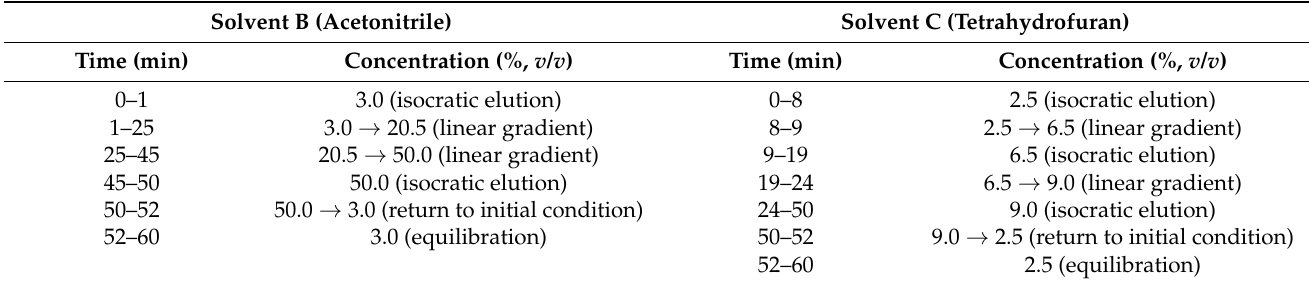
Table 2. Elution profile for HPLC-PDA quantitation of the fruit